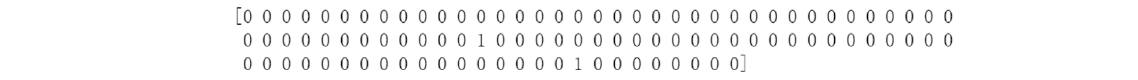
FIGURE 2 | Logistic regression algorithm predicts the top 100 results.